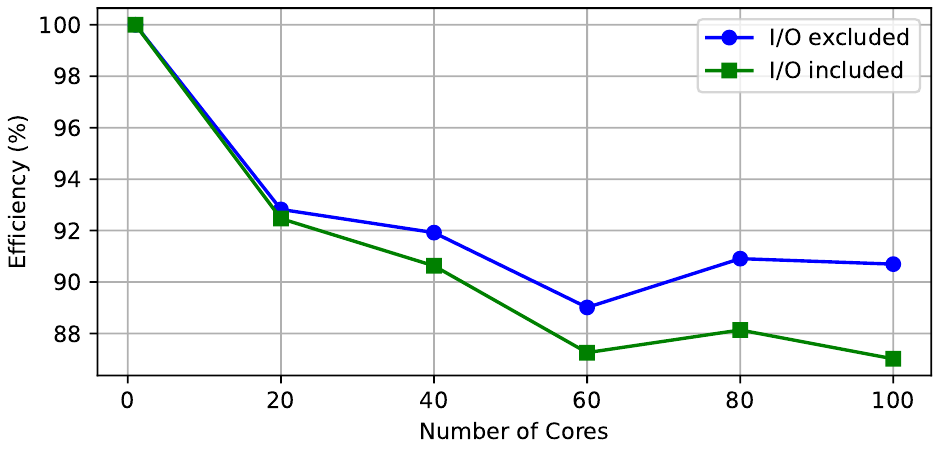
Figure 24. Parallel efficiency of the third-order solver for generating Figure 22.